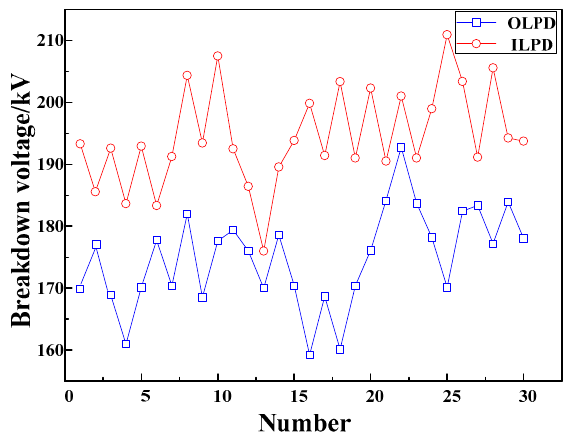
Figure 4. Lightning impulse voltage variation.